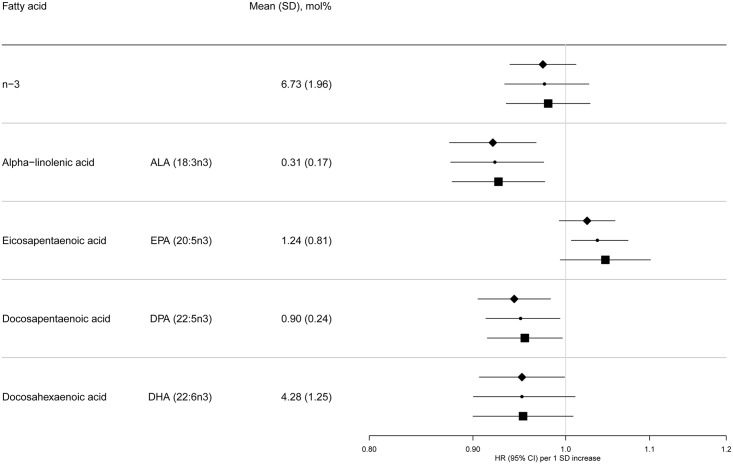
HRs of T2D and 95% CIs per 1 SD increase in total and individual n-3 PUFAs (ALA, EPA, DPA, and DHA): EPIC-InterAct study.Model 1: displayed as diamonds. Age as underlying time variable, and adjusted for centre, sex, physical activity (inactive, moderately inactive, moderately active, or active), smoking (never, former, or current), education level (none, primary school, technical or professional school, secondary school, or higher education), and BMI (continuous, kg/m2). Model 2: displayed as circles. Adjusted as in Model 1 + total energy intake (continuous, kcal/d), alcohol (none, >0–<6, 6–<12, 12–<24 and ≥24 g/d), and (continuous, g/d intake of) meat, fruit and vegetables, dairy products, and soft drinks. Model 3: displayed as squares. Adjusted as in Model 2 + (continuous, g/d intake of) fish and shellfish, nuts and seeds, vegetable oil, olive oil, and margarine.